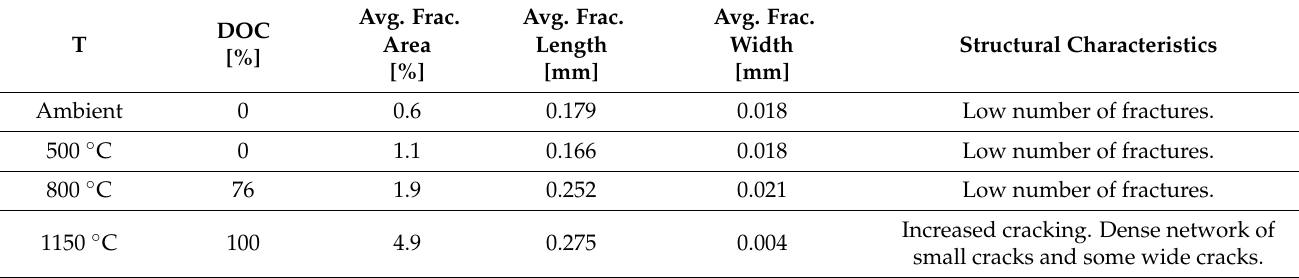
Figure 6. SEM images of limestone and quicklimes of sample 71 (TD = 75%). ( a ) Limestone at ambi ‐ temperature, ( b ) heated to 500 ◦ C, ( c ) heated to 800 ◦ C, and ( d ) heated to 1150 ◦ C. ent temperature, ( b ) heated to 500°C, ( c ) heated to 800°C, and ( d ) heated to 1150°C. Table 4. Summary of image analysis results of fractures for sample 74 (TD = 4%) based on three samples in each temperature group. T = temperature, DOC = degree of calcination, Avg. frac. Area = average fractured area, Avg. frac. Length = average length of fractures, Avg. frac. Width = average width of